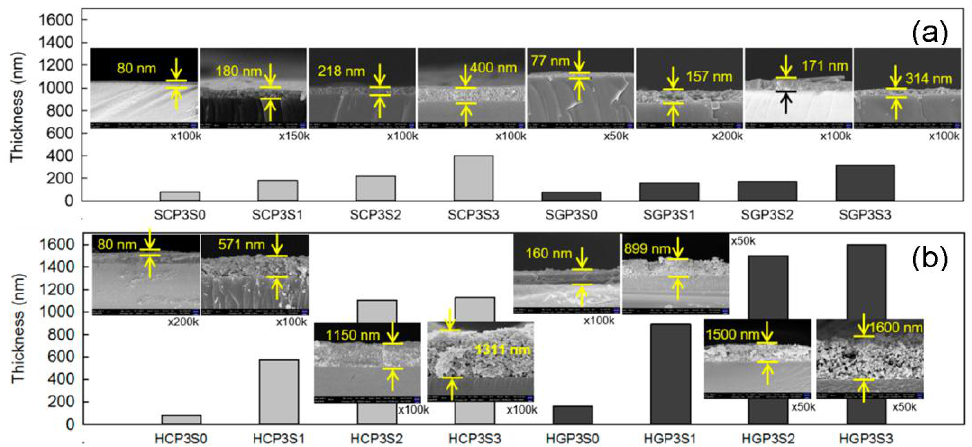
Figure 6. Coating film thickness of photocatalysts after prepared by ( a ) sol-gel hydrolysis; and ( b ) hydrothermal synthesis.